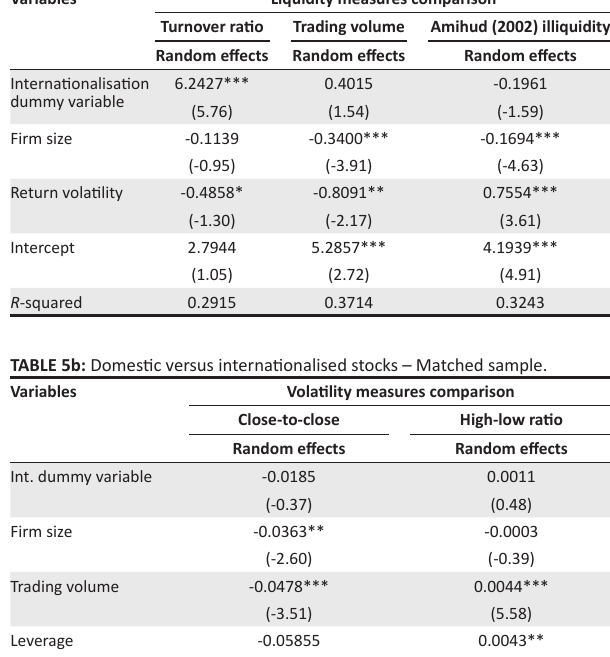
TABLE 5a: Domestic versus internationalised stocks – Matched sample.